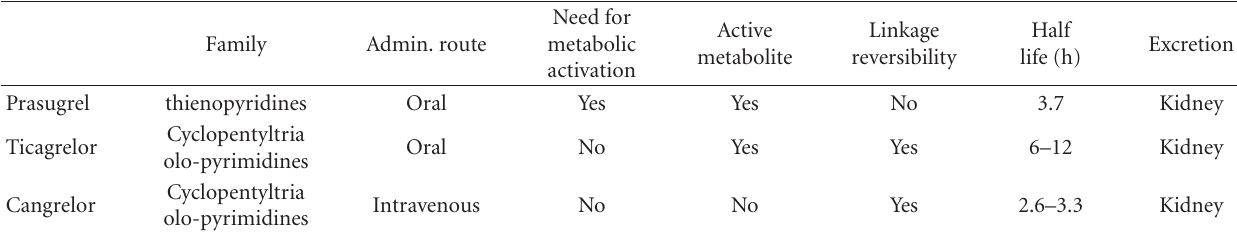
Table 1: Main pharmacodynamic/pharmacokinetic features of novel antiplatelet agents. Family Admin.